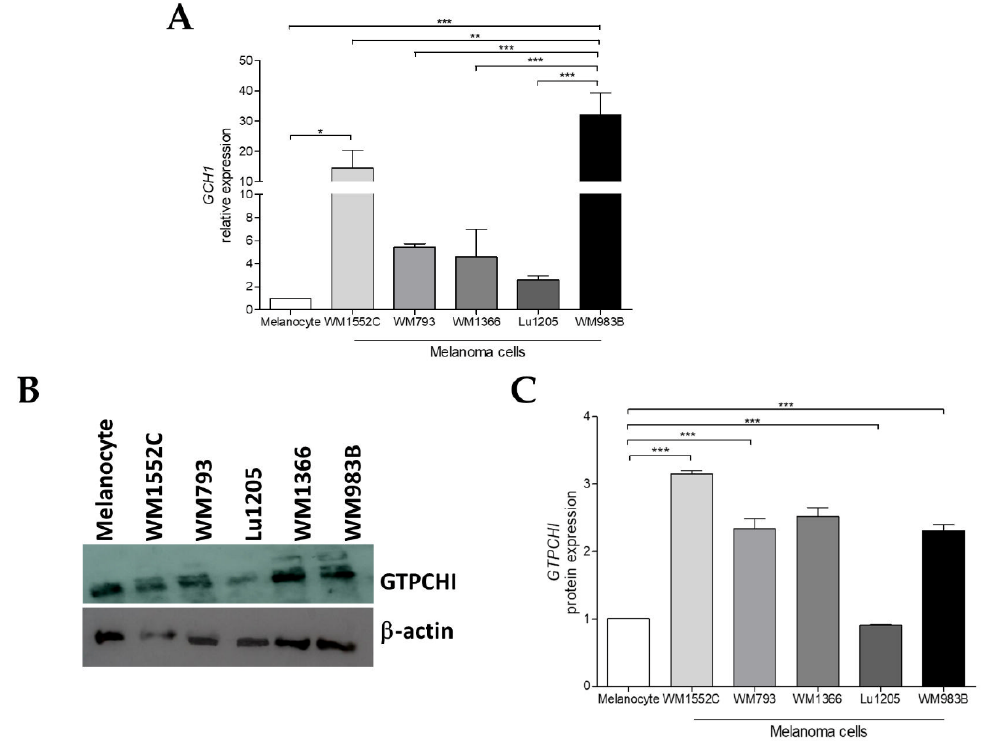
Figure 1. GCH1 expression is higher in melanoma cells. ( A ) Relative mRNA levels of GCH1 were determined in melanocytes, WM1552C, WM793, WM1366, Lu1205, and WM983B melanoma cells by real-time qPCR. ( B , C ) Protein expression of GTPCH1 in melanocytes and melanoma cells were determined by Western blot using a specific antibody. β -actin was used as the internal control. The Western blot image shows a representative result of three independent experiments. Values are reported in the bar graphs and expressed as the means ± S.D. The experiments were performed in triplicate, and p -values were based on the one-way ANOVA test, followed by Bonferroni’s post-test; *, p < 0.05; **, p < 0.01; and ***, p <